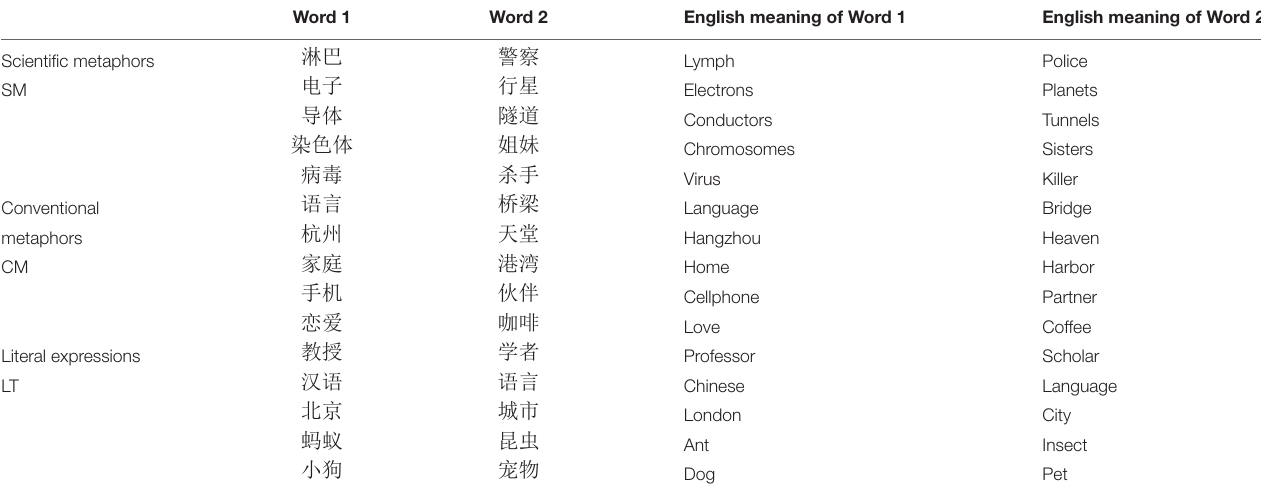
TABLE 1 | Chinese sample stimuli.